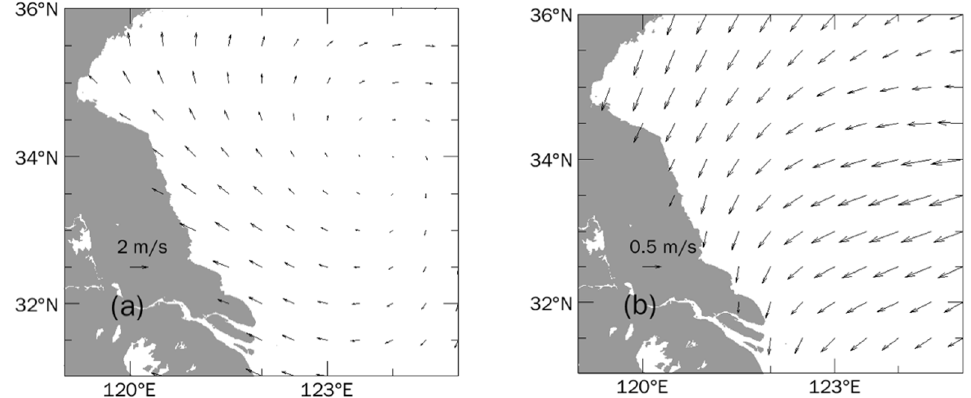
Figure 9. ( a ) Climatological spring wind distribution and ( b ) wind anomaly in the spring of 2021 at 10 m above the southwestern Yellow Sea.